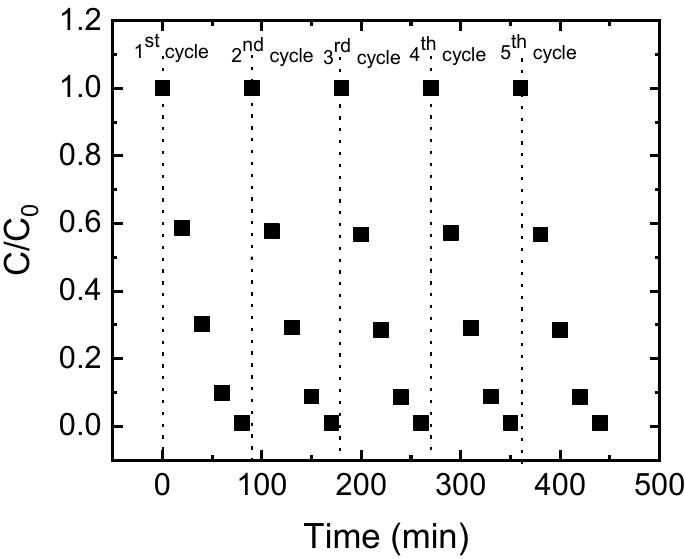
Figure 6. Reusability of the composite nanofibers for the photodegradation of Cr(VI) after 5 cycles. Table 1. Comparison of visible light photodegradation of Cr(VI) using different composite nanofiber photocatalysis.